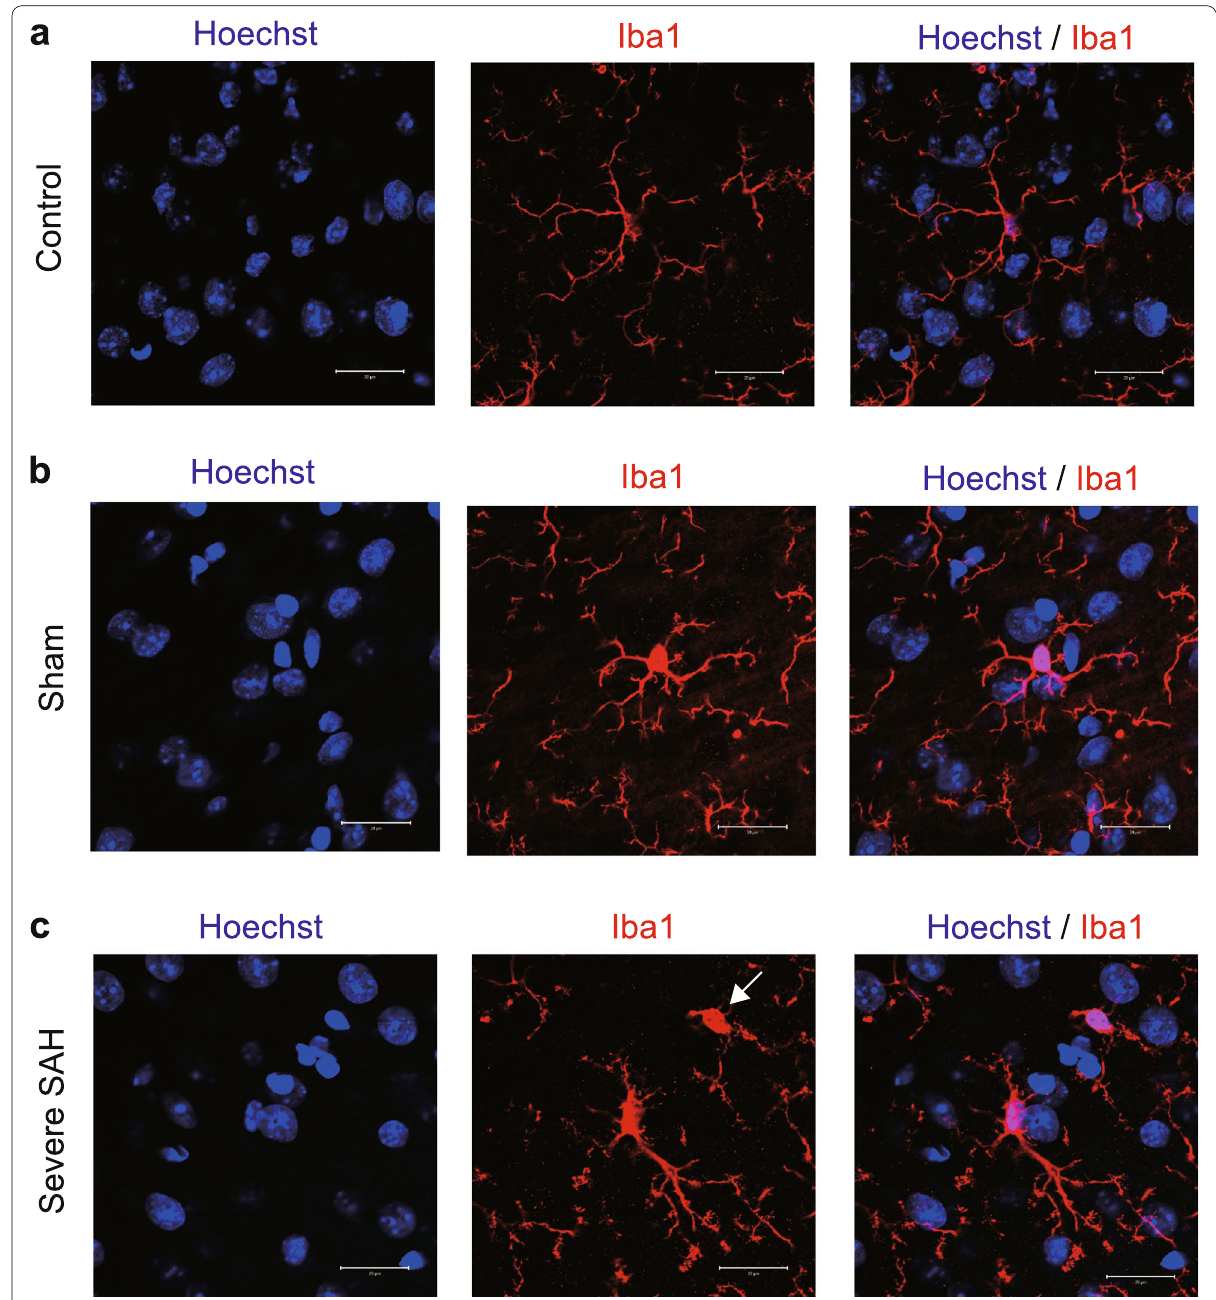
Fig. 7 Microglia are morphologically transformed by SAH. a Immunostaining images of nuclear (blue) and Iba1 (red) staining in the control group; Iba1-positive cells have a ramified shape. b Immunostaining images of nuclear (blue) and Iba1 (red) staining in the sham group; Iba1-positive cells have a ramified shape. c Immunostaining images of nuclear (blue) and Iba1 (red) staining in SAH. Iba1-positive cells are hyperramified or reactive in shape. Some cells were amoeboids, as shown by the white arrows. Scale bars: 20